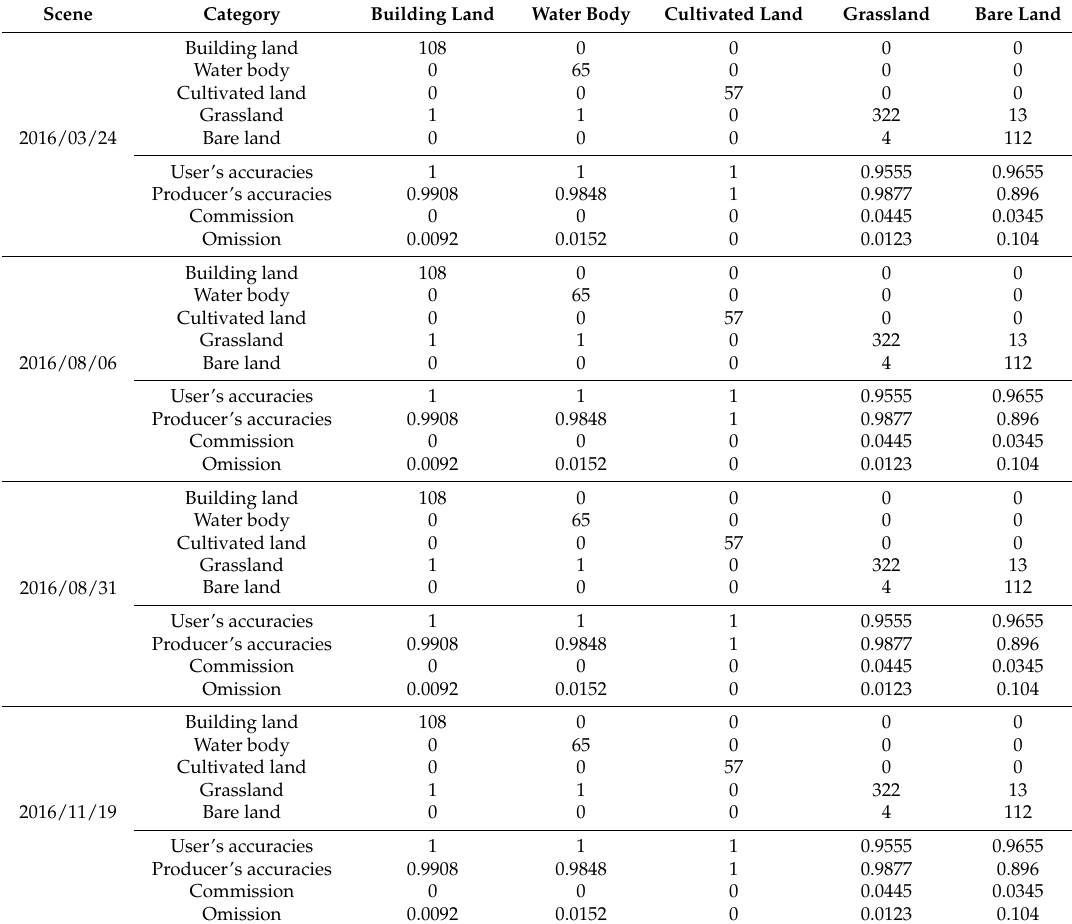
Table 2. The accuracy assessment for the image on